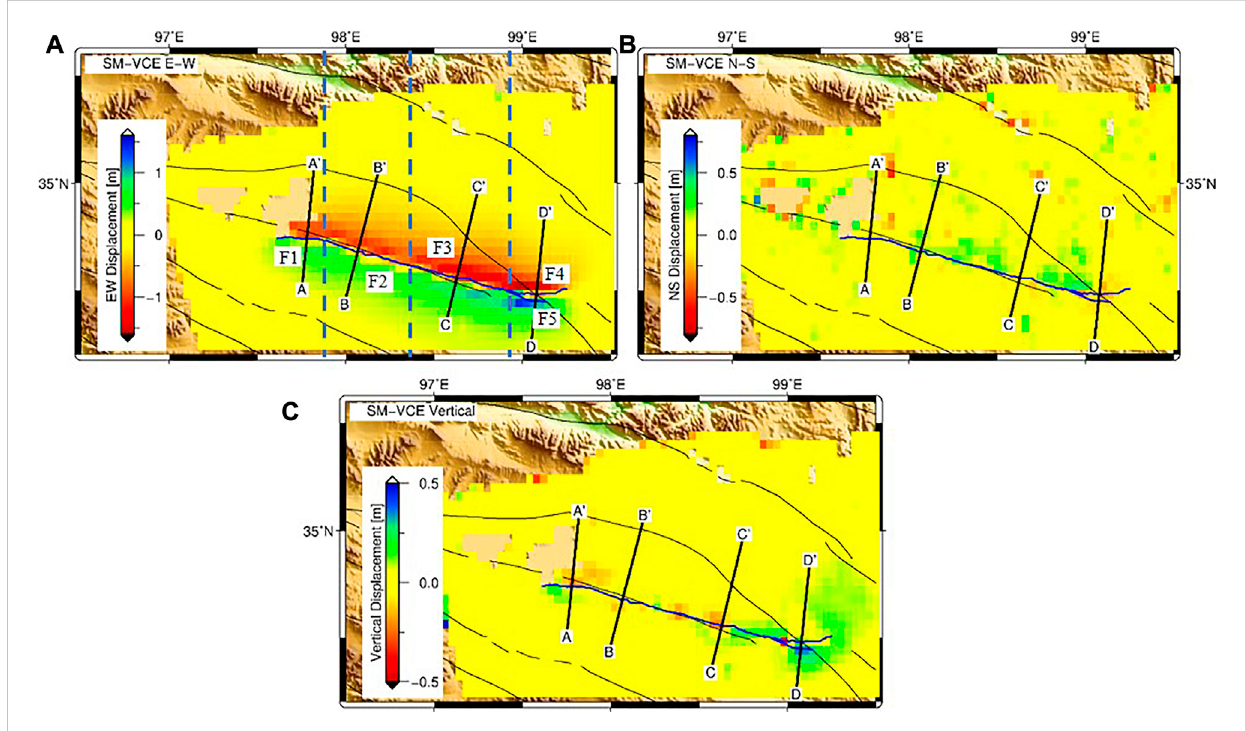
FIGURE 6 Derived 3D dimensional deformation fi elds of Maduo earthquake. (A – C) are the east-west, north-south and vertical components.